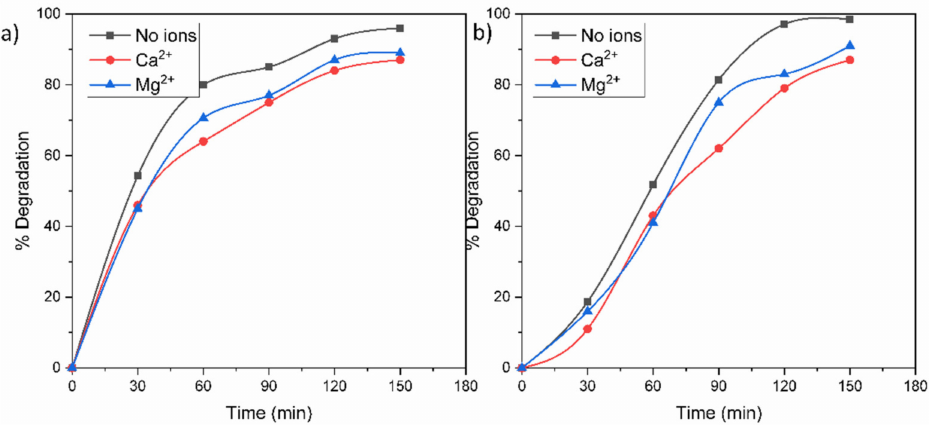
Figure 10. Effect of Ca 2+ and Mg 2+ ions on the photocatalytic degradation of ( a ) RhB and ( b ) MO molecules.